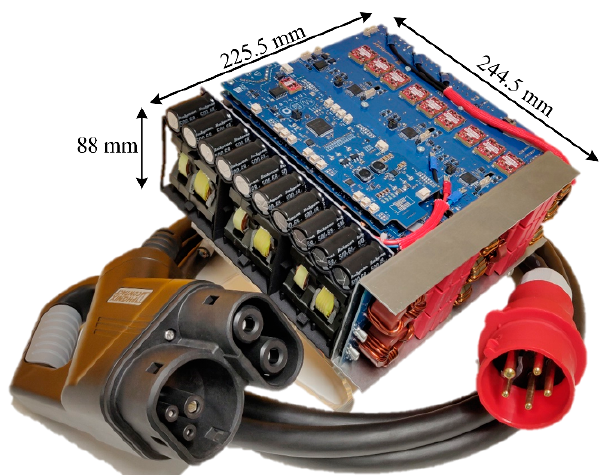
Figure 23. Top view of the 11 kW charging converter with dimensioned edge lengths. The selected CCS Combo2 vehicle connector and the CEE plug are shown for size comparison of the assembled off-board charger.